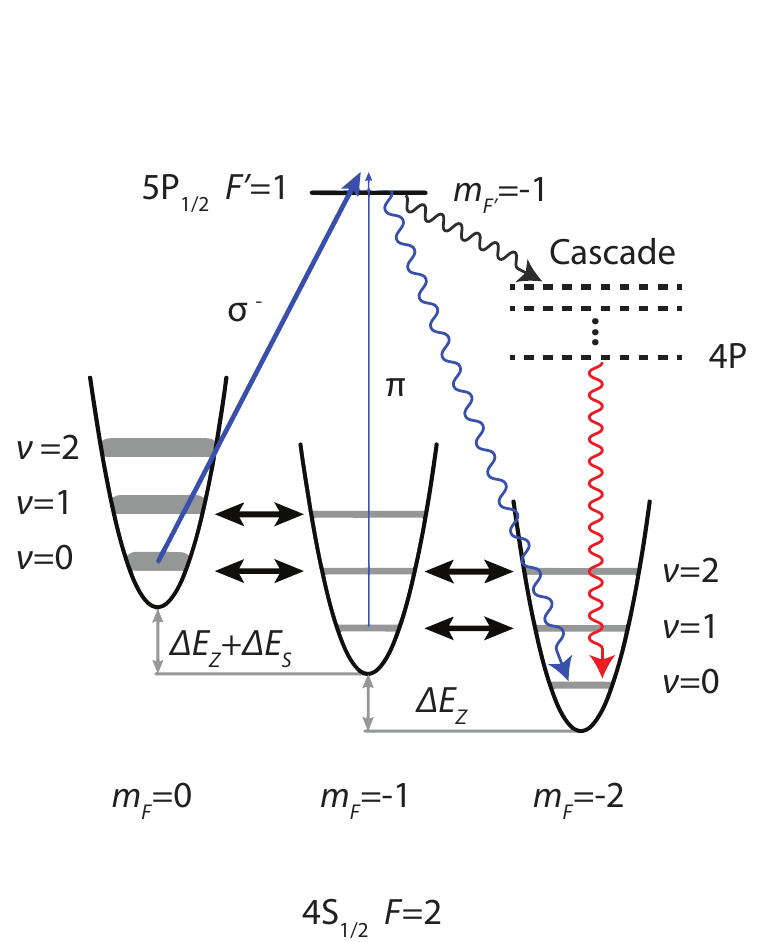
→ 5P Figure 2: The degenerate Raman sideband cooling scheme via the 4S 1 / 2 1 / 2 transition. ∆ E is the Zeeman splitting, which brings the | F = 2, m , ν 〉 state into F Z + 1, ν − 1 〉 state. The double-sided arrows indicate degeneracy with the | F = 2, m F Raman transitions between these states, which are provided by the optical lattice. ∆ E is the light shift of the polarizer beam with σ − polarization. The broadening S of vibrational levels due to the polarizer beam is indicated by the thick grey lines. = − 1 and m = 0 states is indicated by blue arrows. Optical pumping from the m F F The blue wiggled line indicates direct spontaneous decay from the 5P level by 1 / 2 emitting a blue photon, the black wiggled line represents the decay into intermediate states, and the red wiggled line indicates the decay from the 4P manifold to the ground state. Details of the repumping process are given in Ref. [ 33 ]